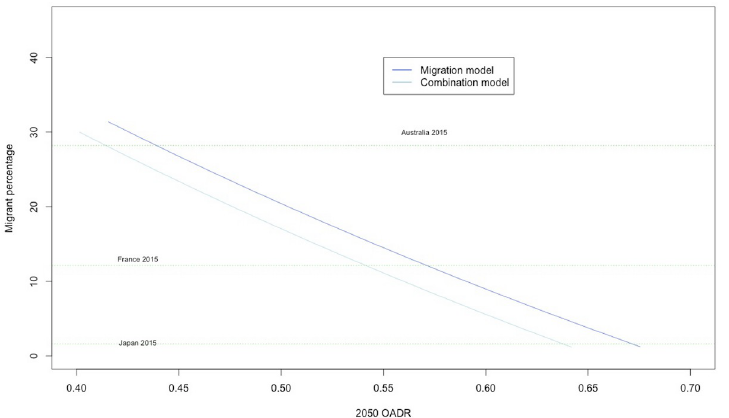
Fig 4. Required migrant populations by 2050 OADR. Assuming a 2020 policy start date. Prior to start date mortality and fertility were held constant at 2014 rates. Combination scenario increases TFR to 1.7 after policy start date alongside additional migrant number.